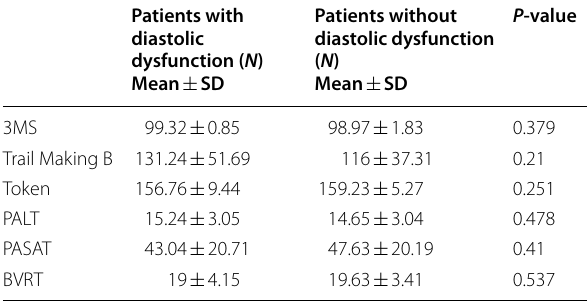
Table 2 Comparison between patients with and without left atrium dilatation regarding cognitive function assessment